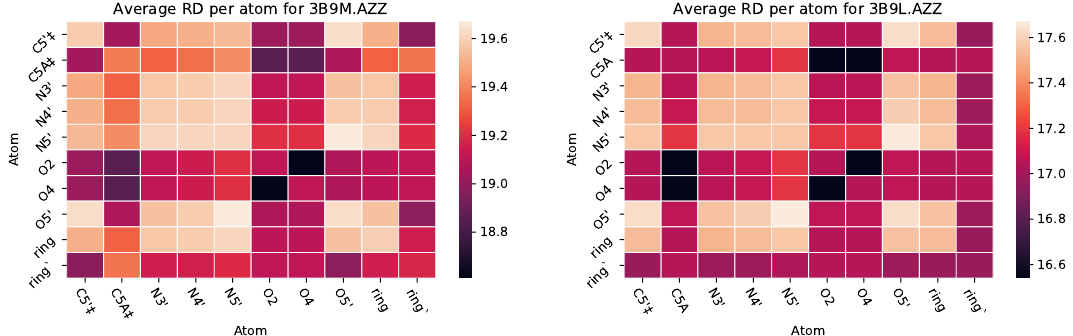
Figure 12. Heat maps for PairCut metrics for HSA in complex with AZT and Myristic Acid (MYR) and SAL (( left ), PDB 3B9M), and in complex with just AZT and MYR (( right ), PDB 3B9L). ‡ designates hydrophobic